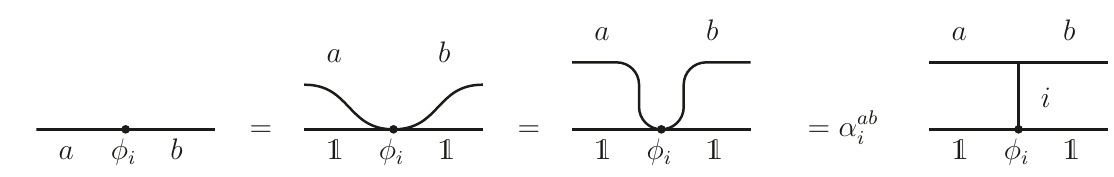
Figure 21 . A boundary field in the i Virasoro representation can be traded for a defect network ending on a defect ending field carrying the same Virasoro representation but sitting on a boundary with the 1 boundary